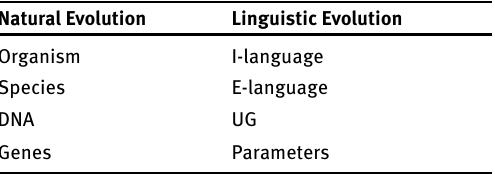
Table 4: Correlation between natural and linguistic evolution (final